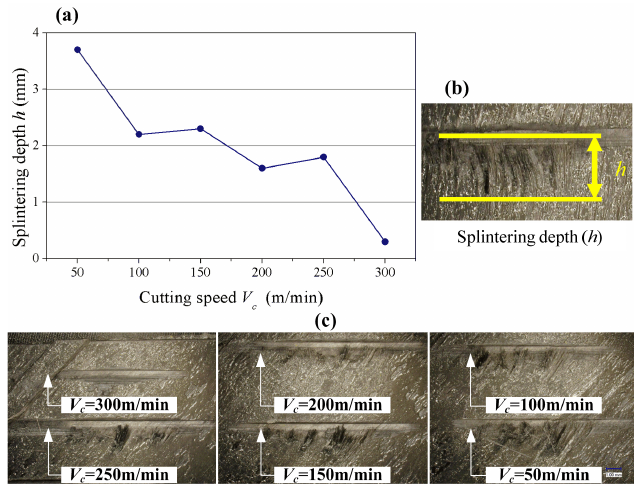
Figure 10. Effects of cutting speed on splintering depth in single point cutting of carbon fiber (45/135°) with PCD tools. ( a ) Line chart; ( b ) Splintering depth; ( c ) The fracture morphology.